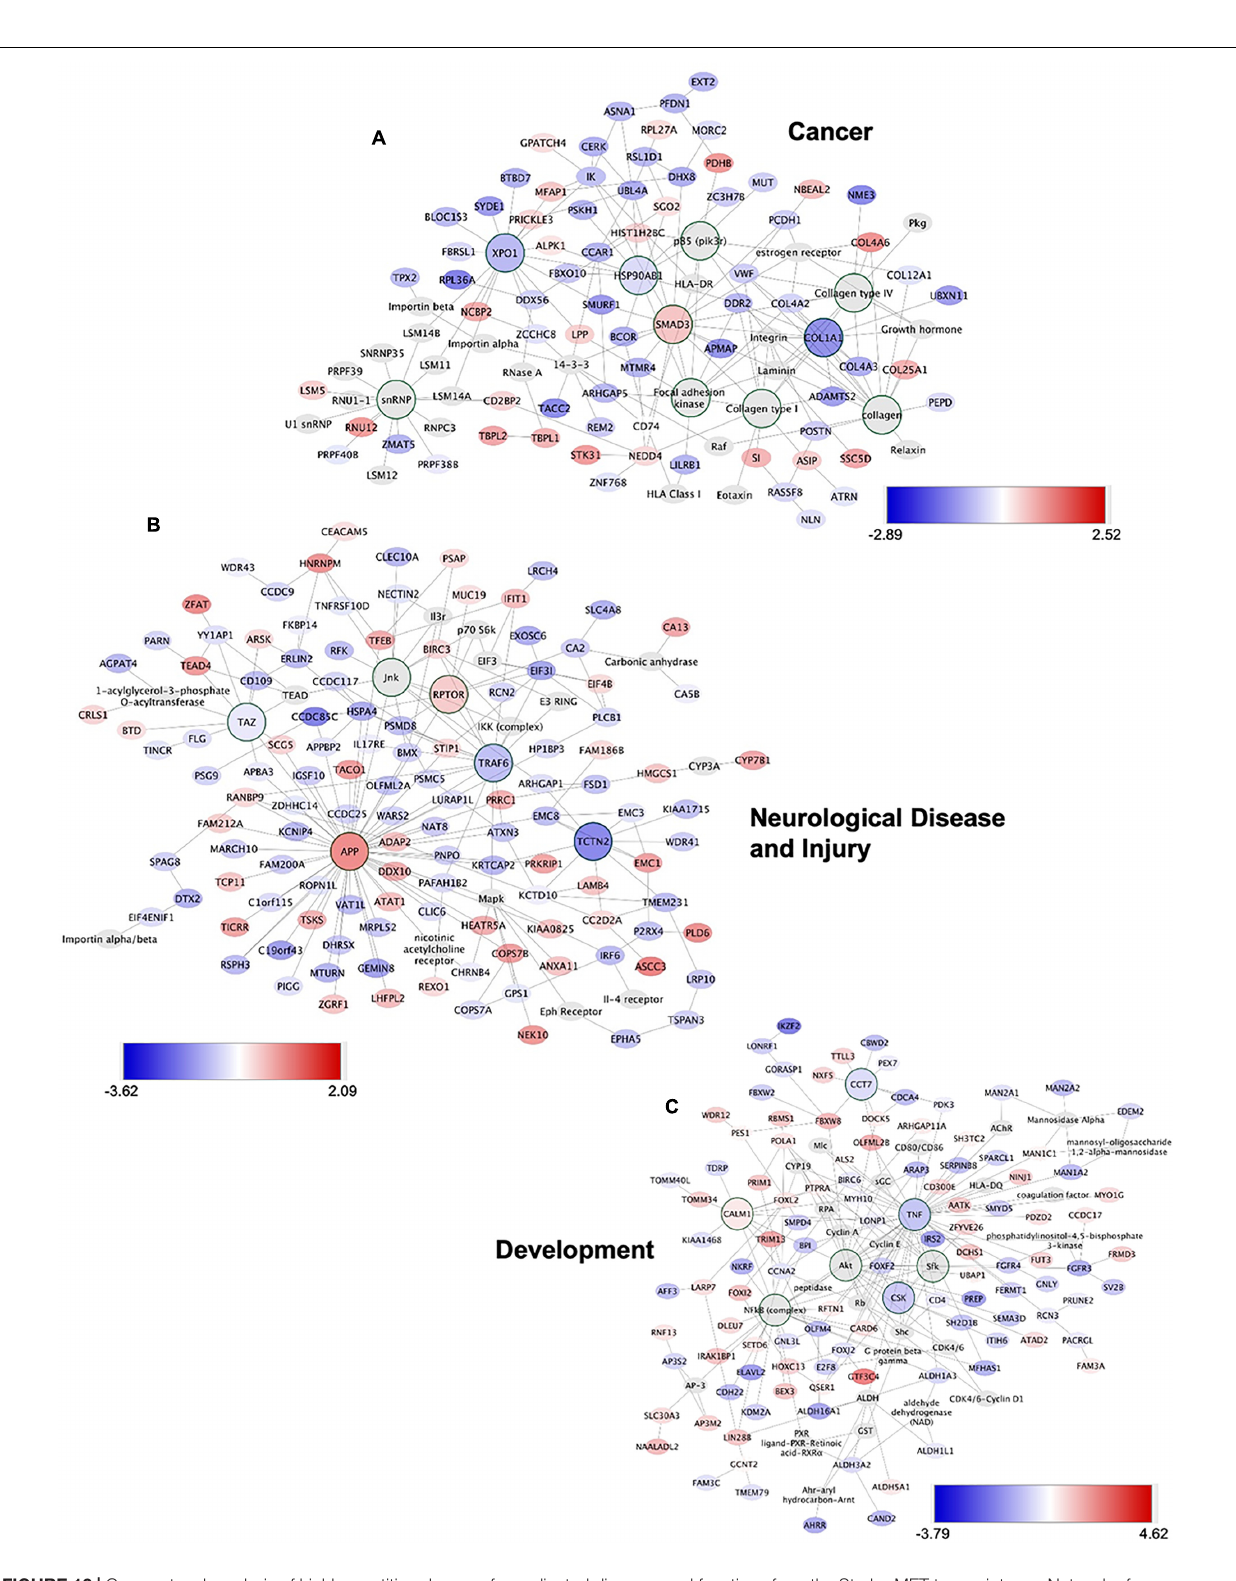
Frontiers in Neuroscience |